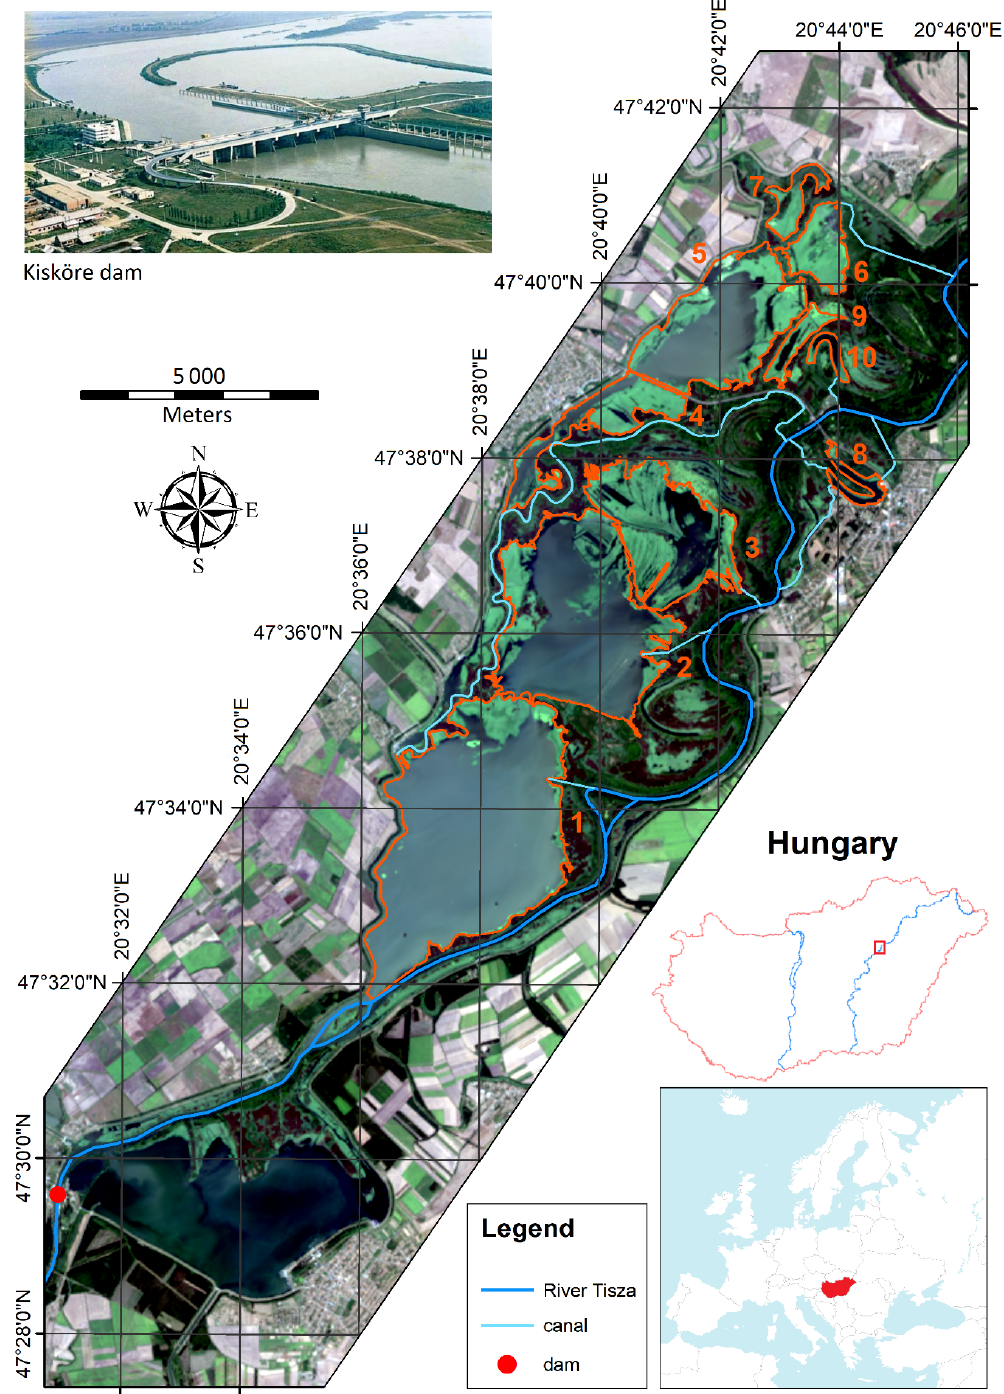
Figure 1. Map of Lake Tisza and sub-basins within the lake (numbers denote basins as in Table 1; basemap: Landsat 8 imagery).